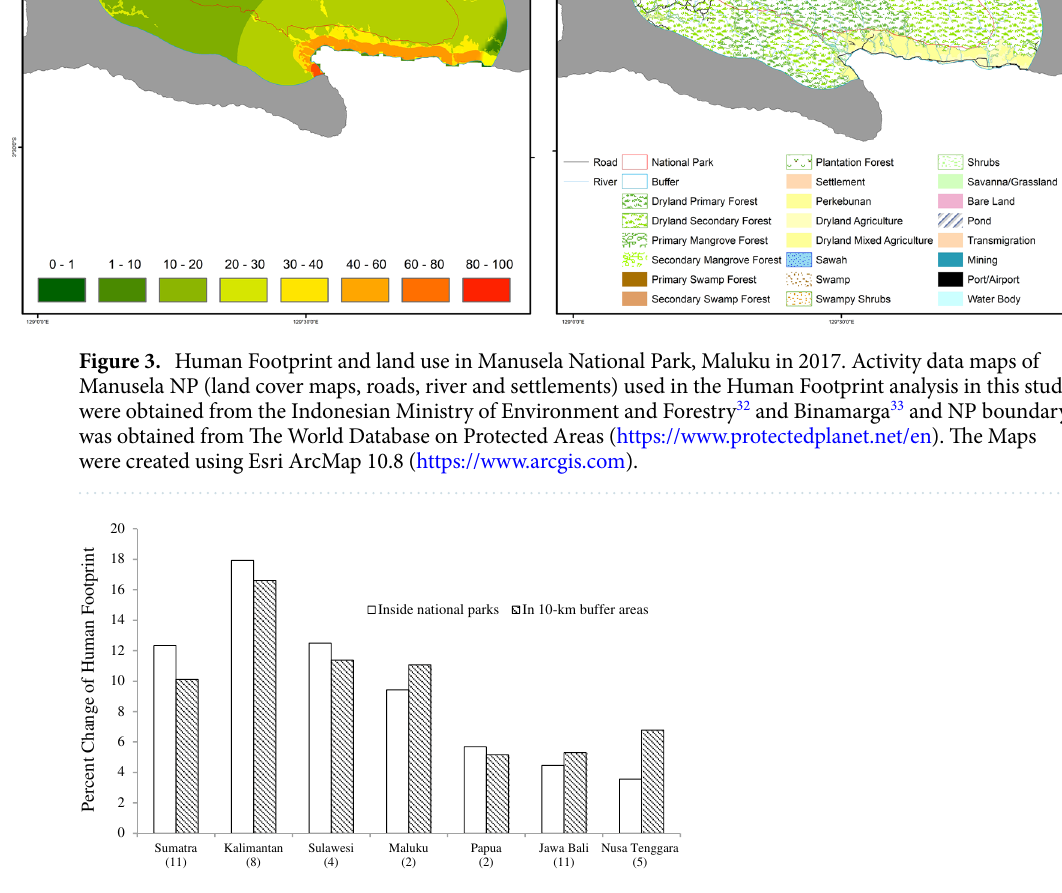
Figure 4. Average percent changes of the Human Footprint in the 7 bioregion of Indonesia between 2012 and